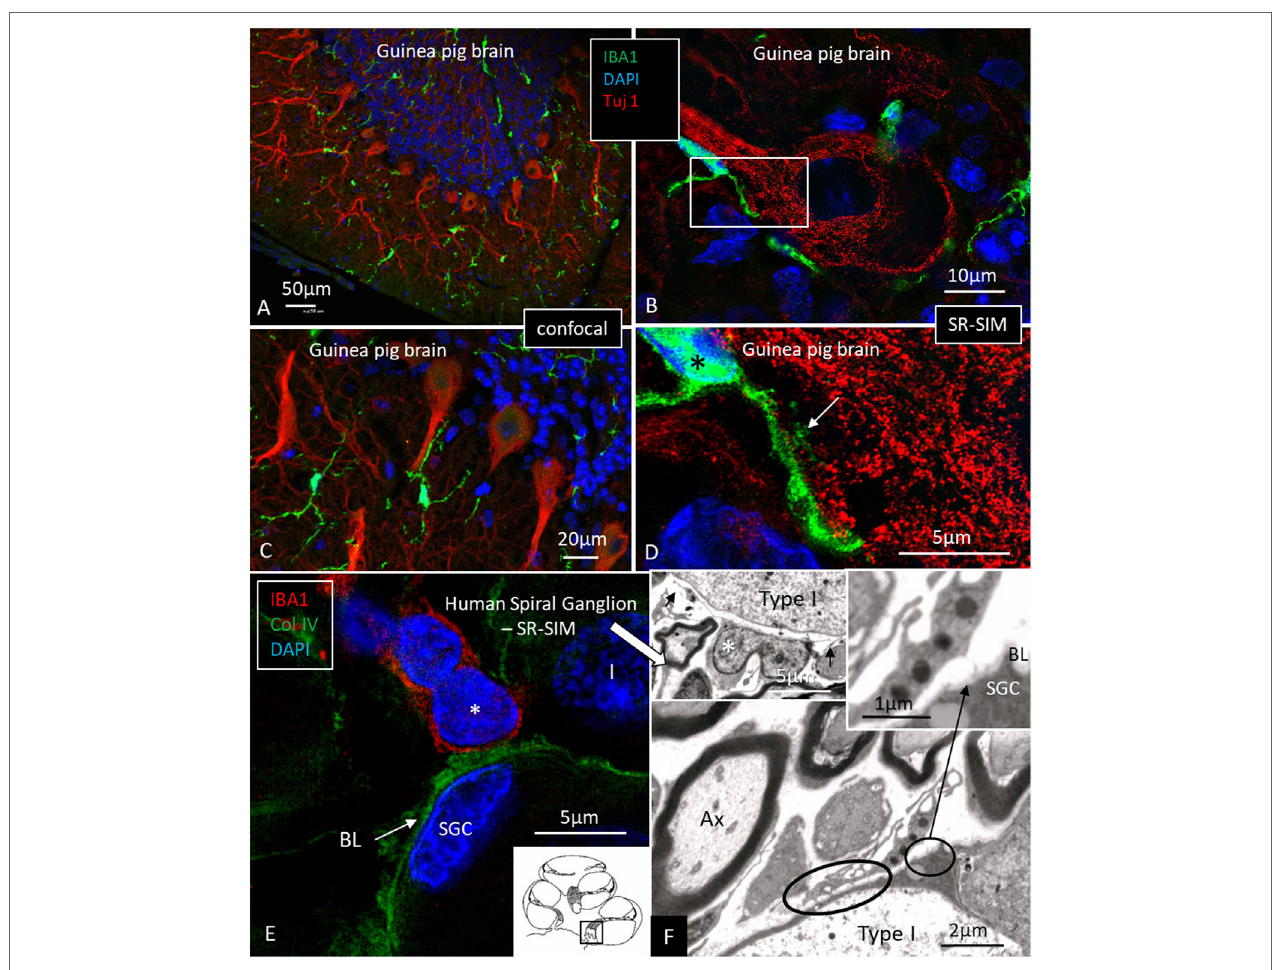
FigUre 5 | Ionized calcium-binding adaptor molecule 1 (IBA1) macrophage interaction in the brain and ear. (a,c) Confocal microscopy of IBA1 and TUJ1 immunoreactivity in the guinea pig bran. IBA1 cells are seen both in the white and gray matter. (b) SR-SIM (maximum intensity projection) show IBA1 cells closely related to the surface of the TUJ1-positive neurons. Framed area is magnified in panel (D) . (D) Higher magnification showing guinea pig brain neurons. IBA1-positive cells are seen in close association with the dendritic processes (arrow). The IBA1 cell nucleus express IBA1 protein (*). (e) SR-SIM of the human spiral ganglion showing IBA1-immunoreactive cell (*) physically related to the collagen IV basal lamina (BL) surrounding the satellite glial cell (SGC). (F) Transmission electron microscopy of human spiral ganglion shows cells believed to represent macrophages (*). They show slender processes (arrows) and contain typical electron-dense bodies (left inset). Cytoplasmic processes project against the outer surface of the SGCs (arrow in right inset). Type I, type I spiral ganglion cell soma; Ax,